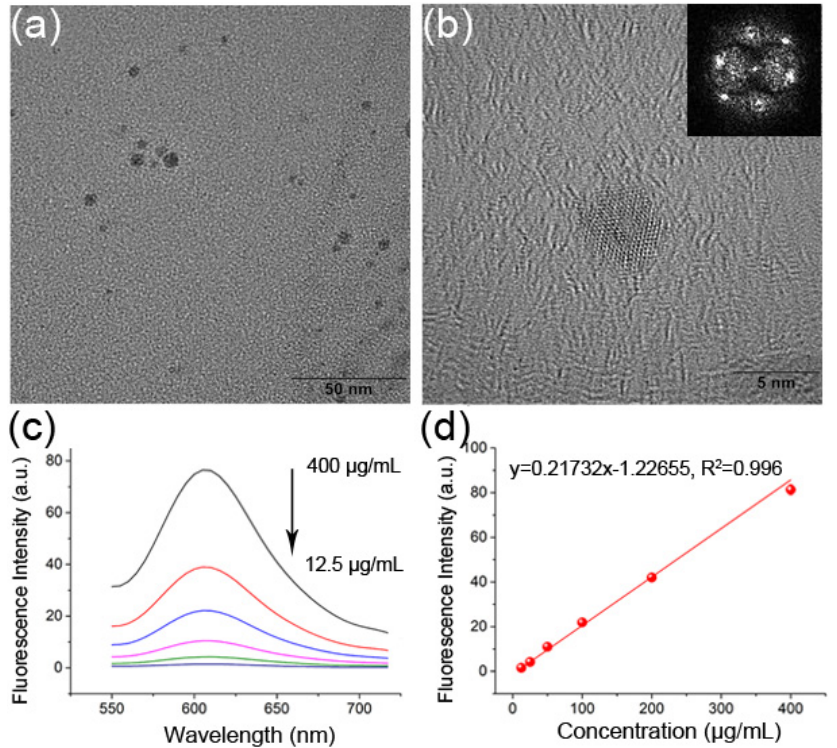
Figure 1. Characterization of GSH-CdTe QDs. TEM images ( a ) and HR-TEM image (Insert: Fourier diffractogram image) ( b ) of GSH-CdTe QDs. Fluorescence spectroscopy ( c ) and the linear relationship between emission fluorescence intensity at 615 nm ( d ) versus 12.5–400 µ g/mL of GSH-CdTe QDs.